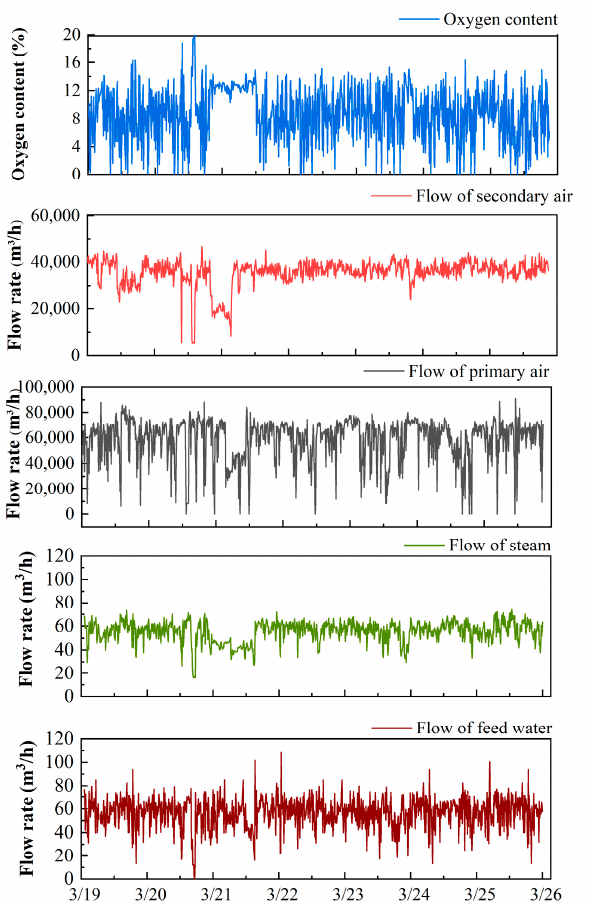
Figure 8. The trend for oxygen content, flow of primary air and secondary air, feed water, and steam.